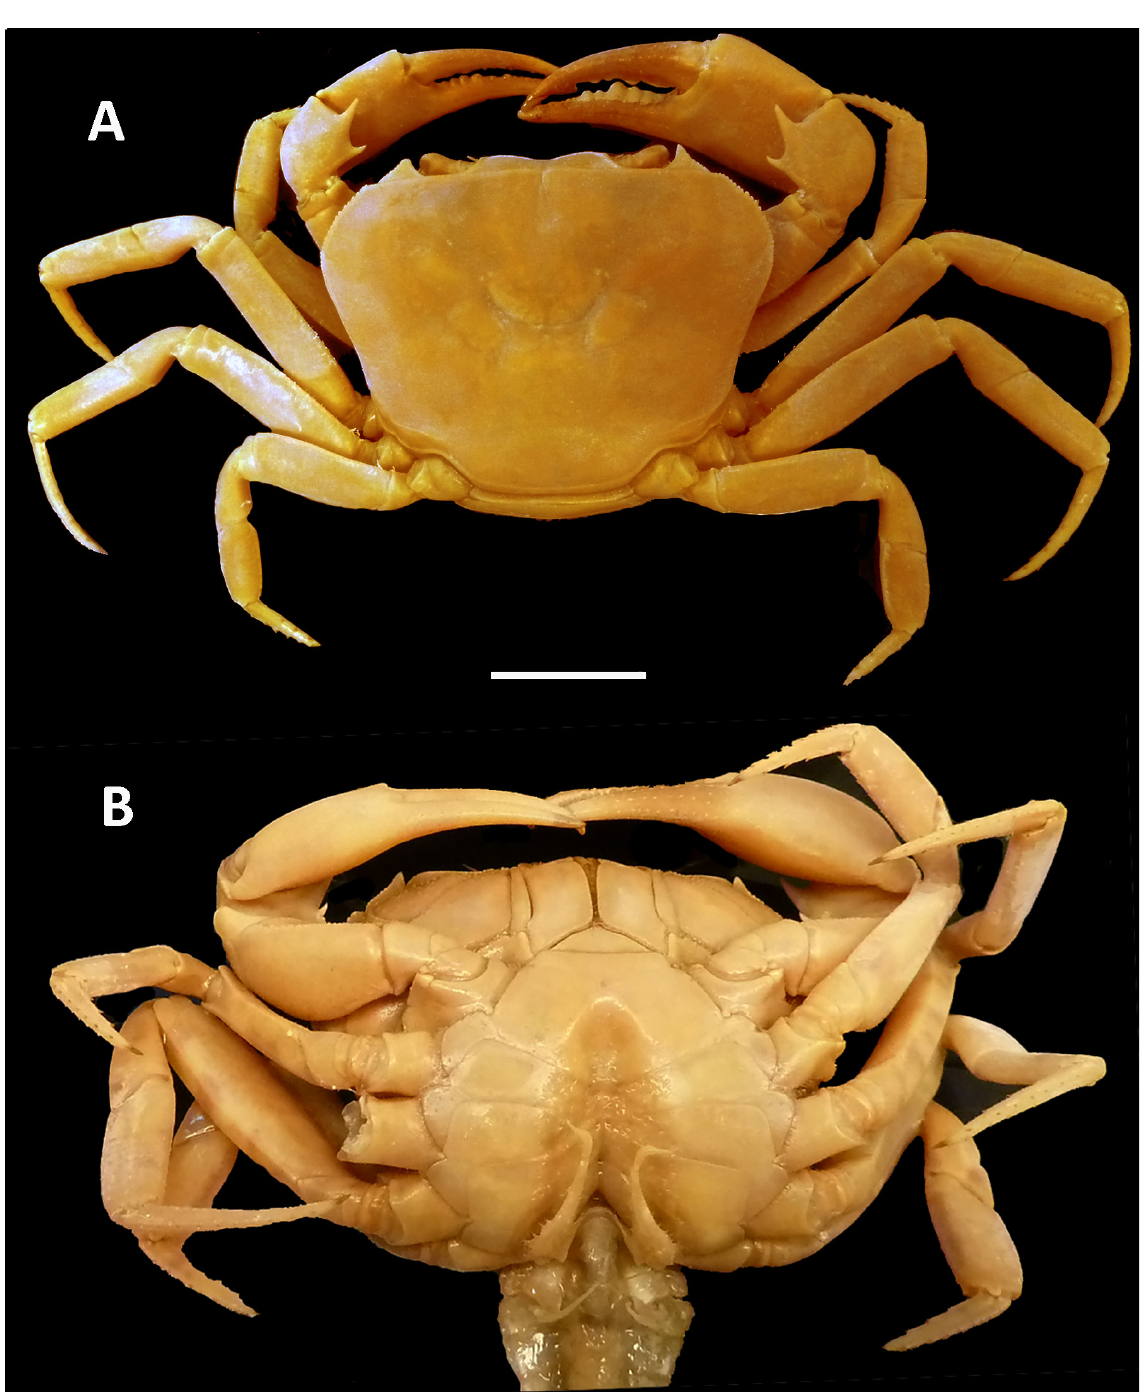
Fig. 8. Potamonautes kisangani sp. nov. A . Adult, ♀, whole animal, dorsal view. B . Adult, ♂, whole animal, ventral view . Scale bar = 10